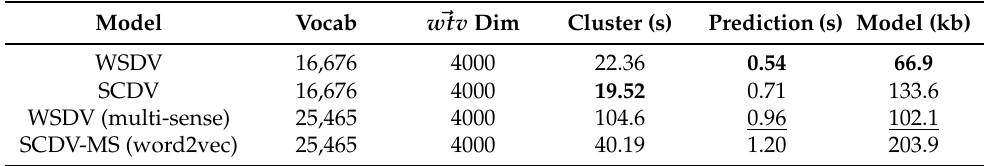
Table 4. Time and Space complexity analysis using the 20Newsgroup dataset (20 clusters).